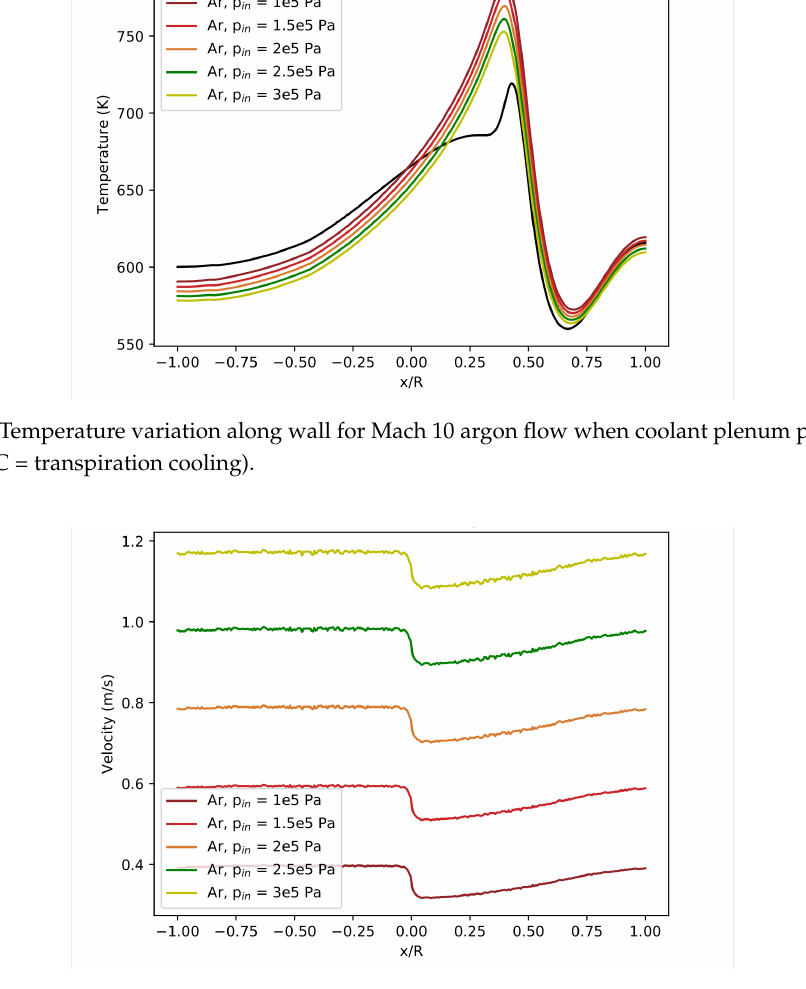
Figure 8. Coolant velocity variation along wall for Mach 10 argon flow when coolant plenum pressure is